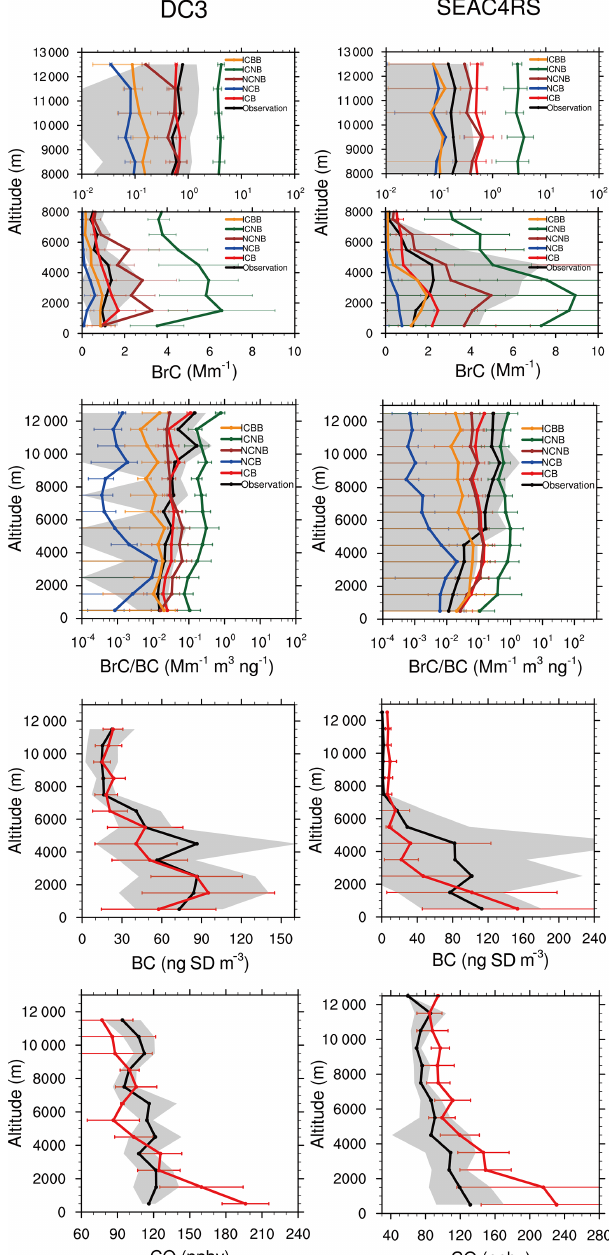
Figure 8. Comparison between observed and simulated vertical profiles of BrC absorption at 365nm, the ratio between BrC absorp- tion at 365nm and BC (BrC / BC), and concentrations of BC and CO for the DC3 (left column) and SEAC4RS (right column) missions. Black lines and shaded areas show the means and standard devia- tions of the observations binned in 1km intervals, respectively. The colored vertical lines and horizontal bars show the means and stan- dard deviations of corresponding model results, respectively. Model sensitivity simulations of BrC are listed in Table 2. The difference among simulated BC and CO vertical profiles is negligible, and the ICB simulation results are